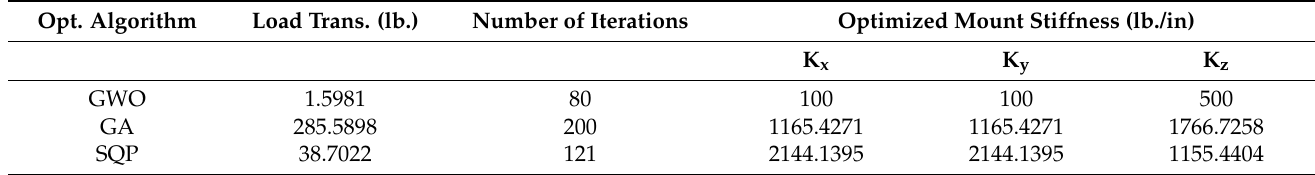
Table 3. Optimized mounts’ stiffness (12-DOF model—shaking loads only).